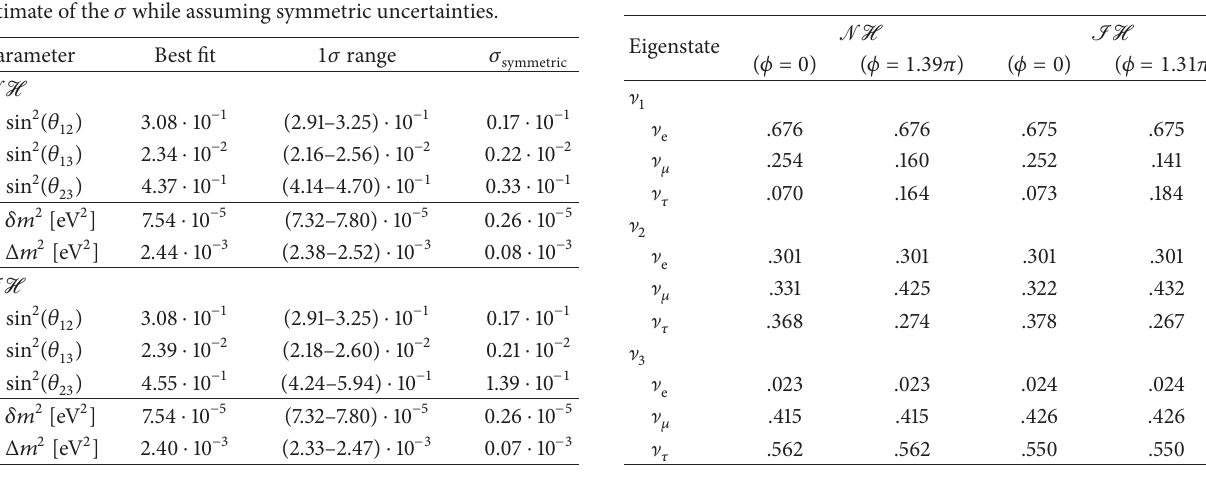
Table 3: Flavor composition of the neutrino mass eigenstates.